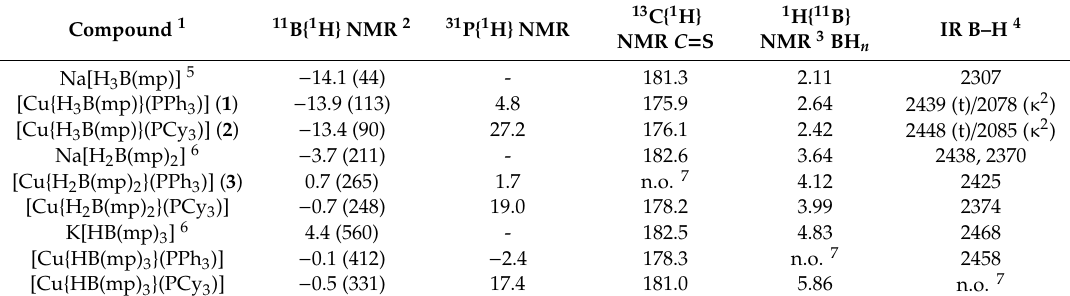
Table 1. Selected NMR (ppm) and IR (cm − 1 ) spectroscopic data for [H n B(mp) 4 − n ] pro-ligands and their corresponding copper complexes.